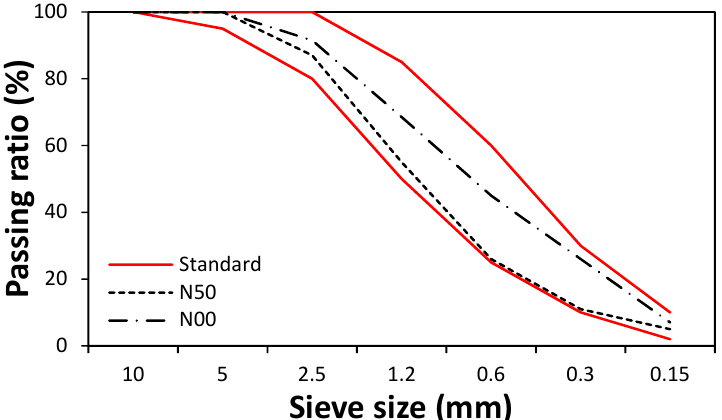
Figure 3. Particle size distribution of mixtures of fine aggregates.